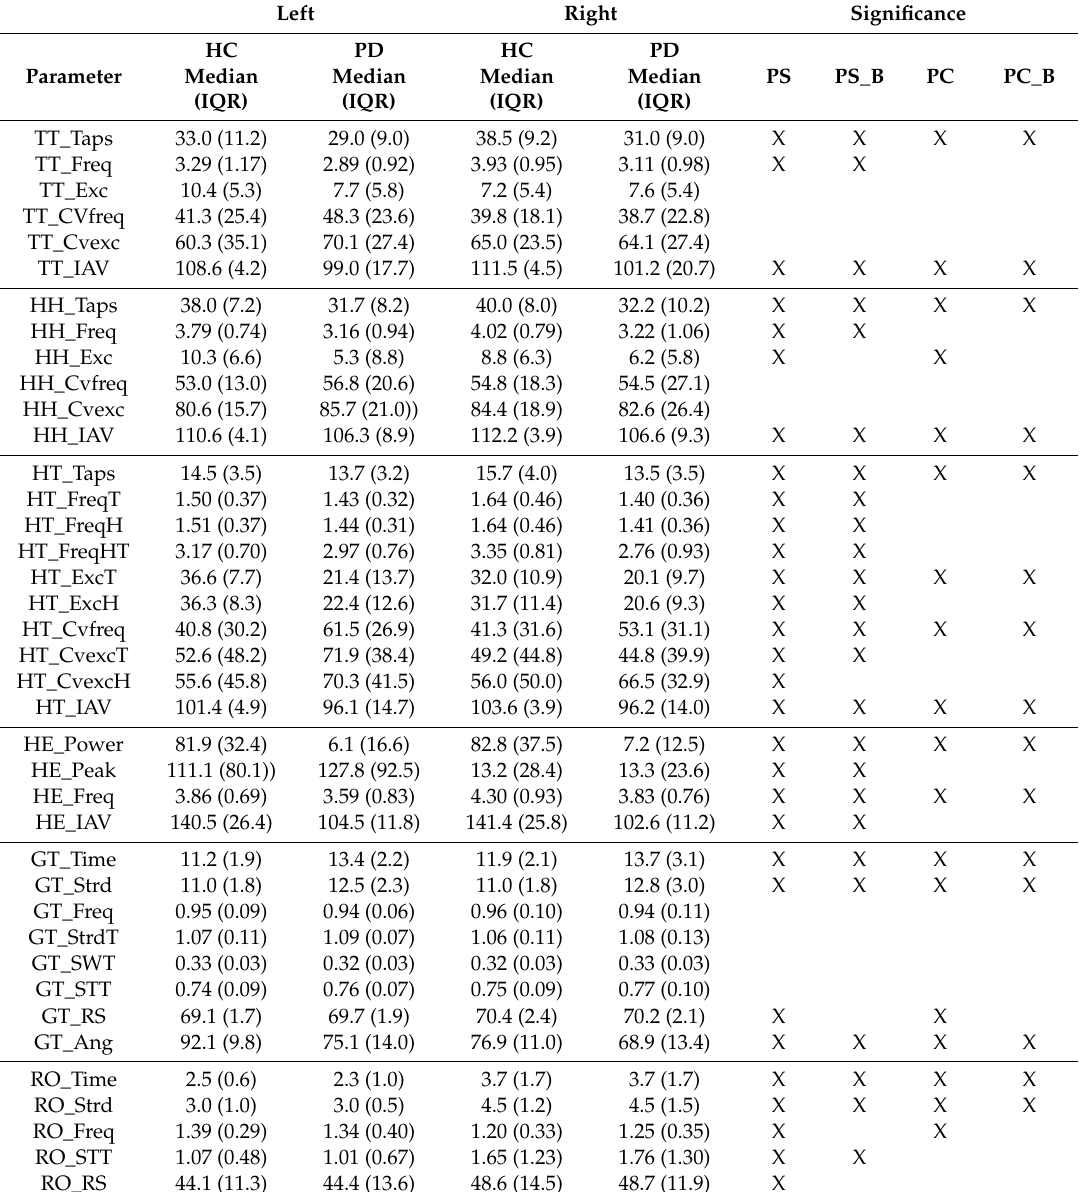
Table 3. Median and interquartile range (IQR) values for parameters extracted from lower limbs for both HC and PD. Significance of parameters in the four datasets (PS, PS_B, PC, PC_B) is marked. Left Right